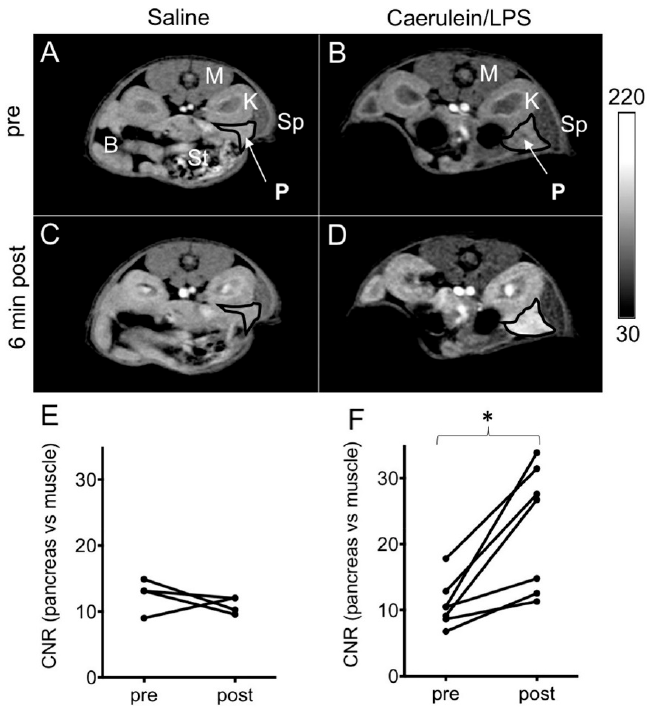
Figure 3 . ( a – d) T 1 -weighted images of saline and caerulein/LPS-treated mice scanned pre- and 6 min post injection of 0.2 mmol/kg Fe 2+ -PyC3A. (e, f) Contrast to noise ratio (CNR) in pancreas vs. 6 min post injection of 0.2 mmol/kg Fe 2+ -PyC3A. ( E , F ) Contrast to noise ratio (CNR) in pancreas vs. muscle before and 6 min after contrast injection; *p < 0.0001. Reprinted (adapted) with permission muscle before and 6 min after contrast injection; * p < 0.0001. Reprinted (adapted) with permission from [46]—Published by American Chemical Society (ACS) . from [46]—Published by American Chemical Society